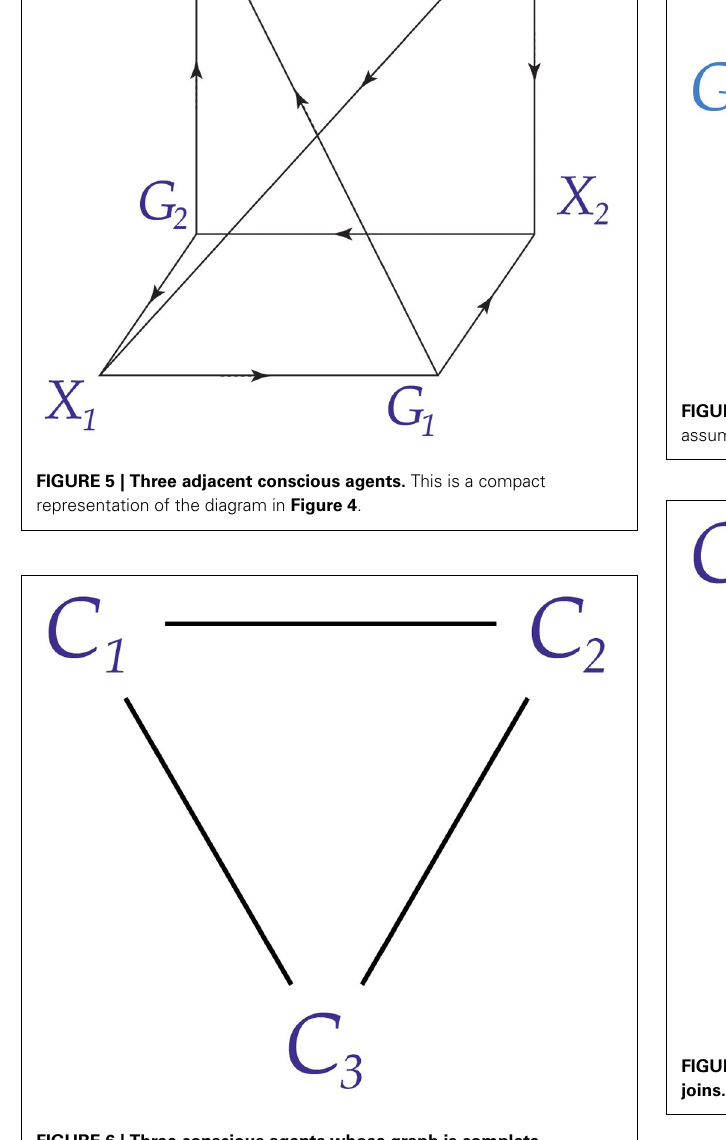
FIGURE 6 | Three conscious agents whose graph is complete.